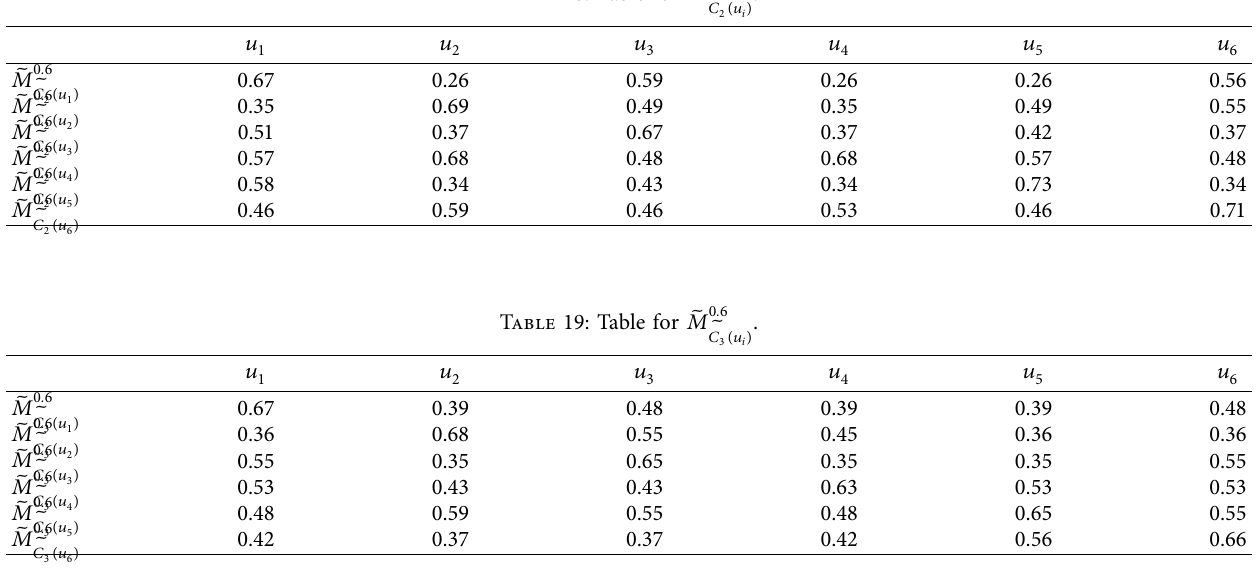
Table 18: Table for 􏽥 M 0 . 6 􏽥